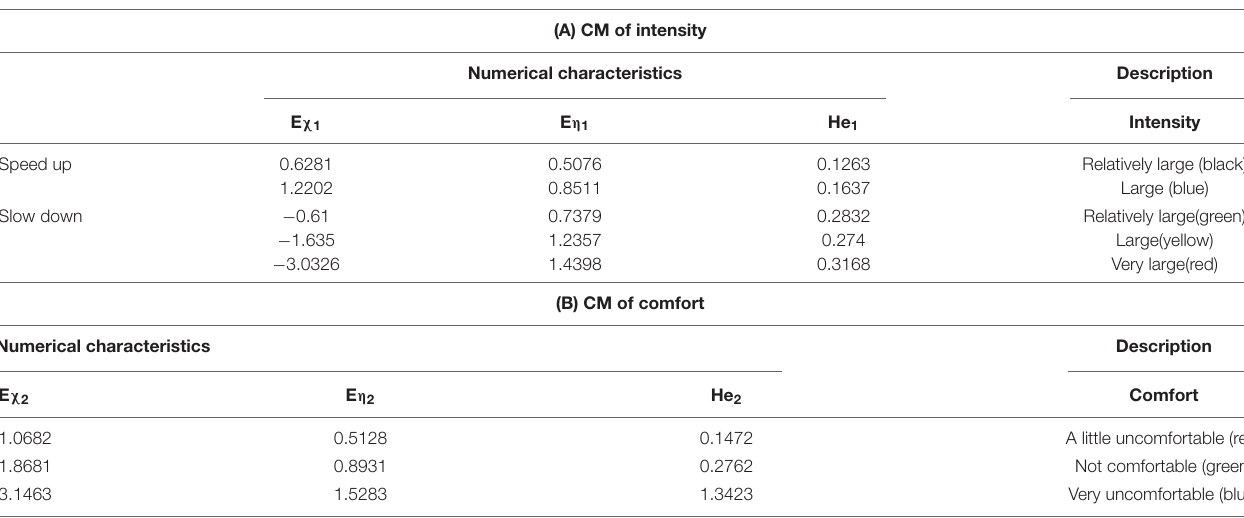
TABLE 2 | Numerical characteristics of cloud models (CMs).